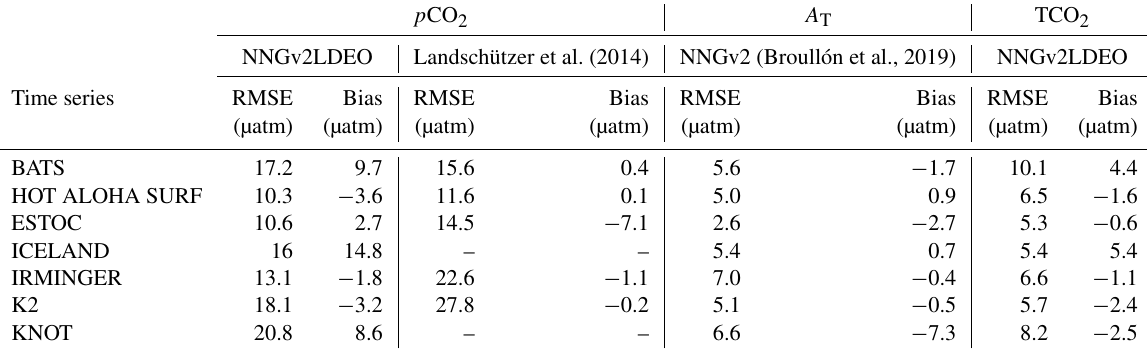
Table 4. RMSE and bias between measured p CO 2 (and in some cases, computed from measured A T and TCO 2 in time series where p CO 2 was not measured) and computed p CO 2 with A T from NNGv2 (Broullón et al., 2019) and TCO 2 from NNGv2LDEO in several time series. The time period for p CO 2 from this study is the same as in Table 3. Consult Table 2 in Landschützer et al. (2014) for its time period. The depth range is 0–15m. Only time series with more than 30 data points are included. RMSE and bias for computed A T with NNGv2 (Broullón et al., 2019) and TCO 2 with NNGv2LDEO are included to show the errors in the variables used to compute TCO 2 . p CO